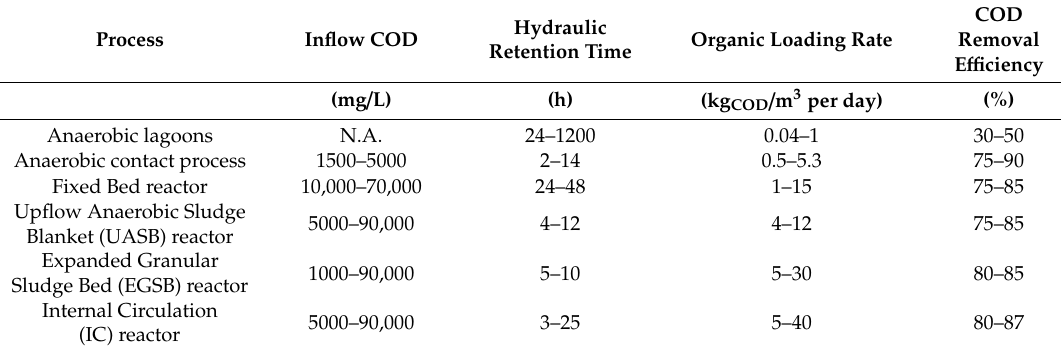
Table 6. Typical processes and performance data of anaerobic technologies used for industrial wastewater treatment